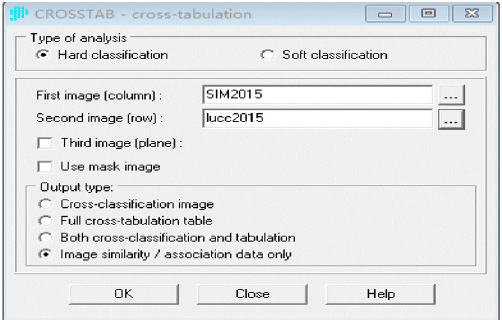
Figure 10. Calculation of Kappa coefficient by CROSSTAB module. Table 5. The probability transfer matrix of land use from 2015 to 2050 under the status quo continuation scenario.